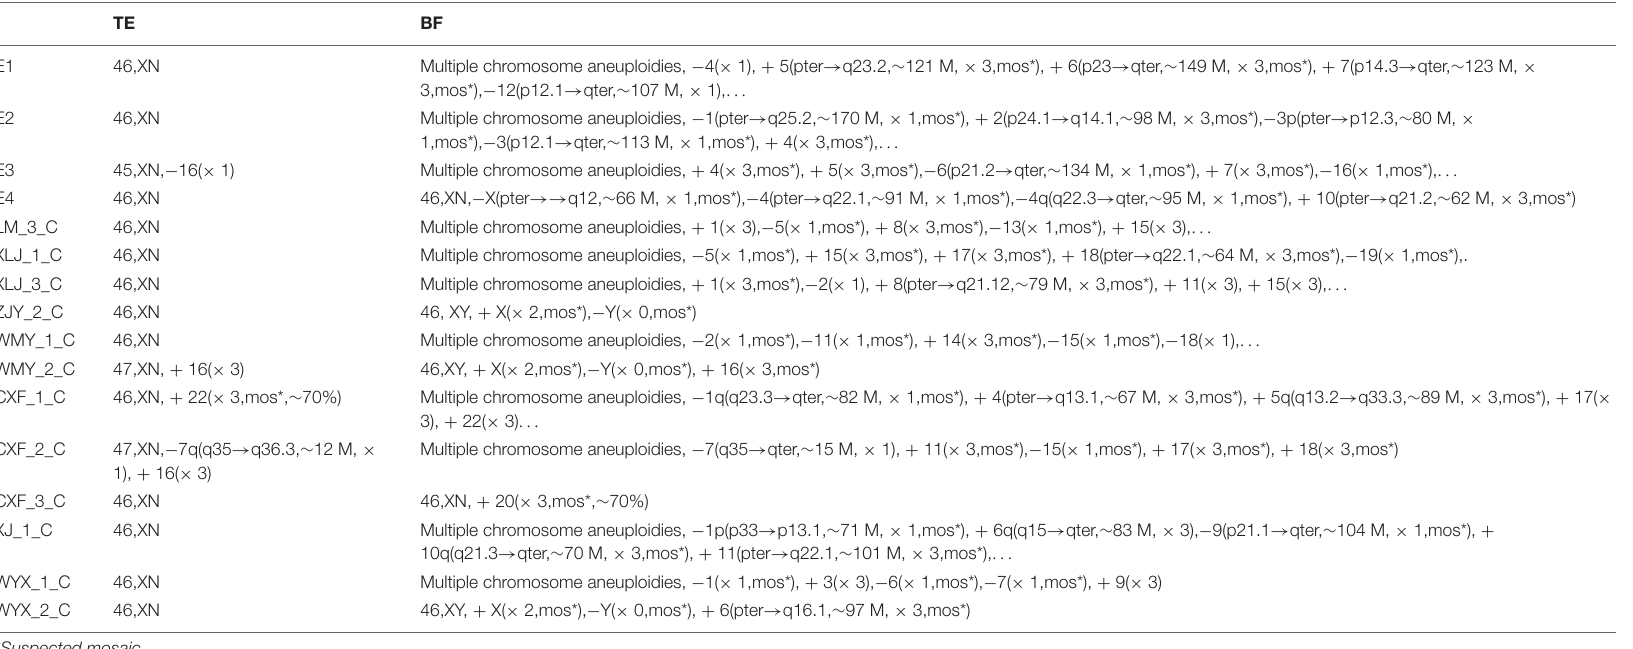
TABLE 3 | Molecular karyotypes of blastocoel fluid (BF) and trophectoderm (TE). TE BF E1 46,XN Multiple chromosome aneuploidies, − 4( × 1), + 5(pter → q23.2, ∼ 121 M, × 3,mos*), + 6(p23 → qter, ∼ 149 M, × 3,mos*), + 7(p14.3 → qter, ∼ 123 M, × 3,mos*), − 12(p12.1 → qter, ∼ 107 M, × 1), ... E2 46,XN Multiple chromosome aneuploidies, − 1(pter → q25.2, ∼ 170 M, × 1,mos*), + 2(p24.1 → q14.1, ∼ 98 M, × 3,mos*), − 3p(pter → p12.3, ∼ 80 M, × 1,mos*), − 3(p12.1 → qter, ∼ 113 M, × 1,mos*), + 4( × 3,mos*), ... E3 45,XN, − 16( × 1) Multiple chromosome aneuploidies, + 4( × 3,mos*), + 5( × 3,mos*), − 6(p21.2 → qter, ∼ 134 M, × 1,mos*), + 7( × 3,mos*), − 16( × 1,mos*), ... 46,XN 46,XN, − X(pter →→ q12, ∼ 66 M, × 1,mos*), − 4(pter → q22.1, ∼ 91 M, × 1,mos*), − 4q(q22.3 → qter, ∼ 95 M, × 1,mos*), + 10(pter → q21.2, ∼ 62 M, × 3,mos*) 46,XN Multiple chromosome aneuploidies, + 1( × 3), − 5( × 1,mos*), + 8( × 3,mos*), − 13( × 1,mos*), + 15( × 3), ... 46,XN Multiple chromosome aneuploidies, − 5( × 1,mos*), + 15( × 3,mos*), + 17( × 3,mos*), + 18(pter → q22.1, ∼ 64 M, × 3,mos*), − 19( × 1,mos*),. Multiple chromosome aneuploidies, + 1( × 3,mos*), − 2( × 1), + 8(pter → q21.12, ∼ 79 M, × 3,mos*), + 11( × 3), + 15( × 3), ... 46, XY, + X( × 2,mos*), − Y( × 0,mos*) Multiple chromosome aneuploidies, − 2( × 1,mos*), − 11( × 1,mos*), + 14( × 3,mos*), − 15( × 1,mos*), − 18( × 1), ... 47,XN, + 16( × 3) 46,XY, + X( × 2,mos*), − Y( × 0,mos*), + 16( × 3,mos*) 46,XN, + 22( × 3,mos*, ∼ 70%) Multiple chromosome aneuploidies, − 1q(q23.3 → qter, ∼ 82 M, × 1,mos*), + 4(pter → q13.1, ∼ 67 M, × 3,mos*), + 5q(q13.2 → q33.3, ∼ 89 M, × 3,mos*), + 17( × 3), + 22( × 3) ... CXF_2_C 47,XN, − 7q(q35 → q36.3, ∼ 12 M, × Multiple chromosome aneuploidies, − 7(q35 → qter, ∼ 15 M, × 1), + 11( × 3,mos*), − 15( × 1,mos*), + 17( × 3,mos*), + 18( × 3,mos*) 1), + 16( × 3) 46,XN 46,XN, + 20( × 3,mos*, ∼ 70%) 46,XN Multiple chromosome aneuploidies, − 1p(p33 → p13.1, ∼ 71 M, × 1,mos*), + 6q(q15 → qter, ∼ 83 M, × 3), − 9(p21.1 → qter, ∼ 104 M, × 1,mos*), + 10q(q21.3 → qter, ∼ 70 M, × 3,mos*), + 11(pter → q22.1, ∼ 101 M, × 3,mos*), ... 46,XN Multiple chromosome aneuploidies, − 1( × 1,mos*), + 3( × 3), − 6( × 1,mos*), − 7( × 1,mos*), + 9( × 3) 46,XN 46,XY, + X( × 2,mos*), − Y( × 0,mos*), + 6(pter → q16.1, ∼ 97 M, × 3,mos*) *Suspected